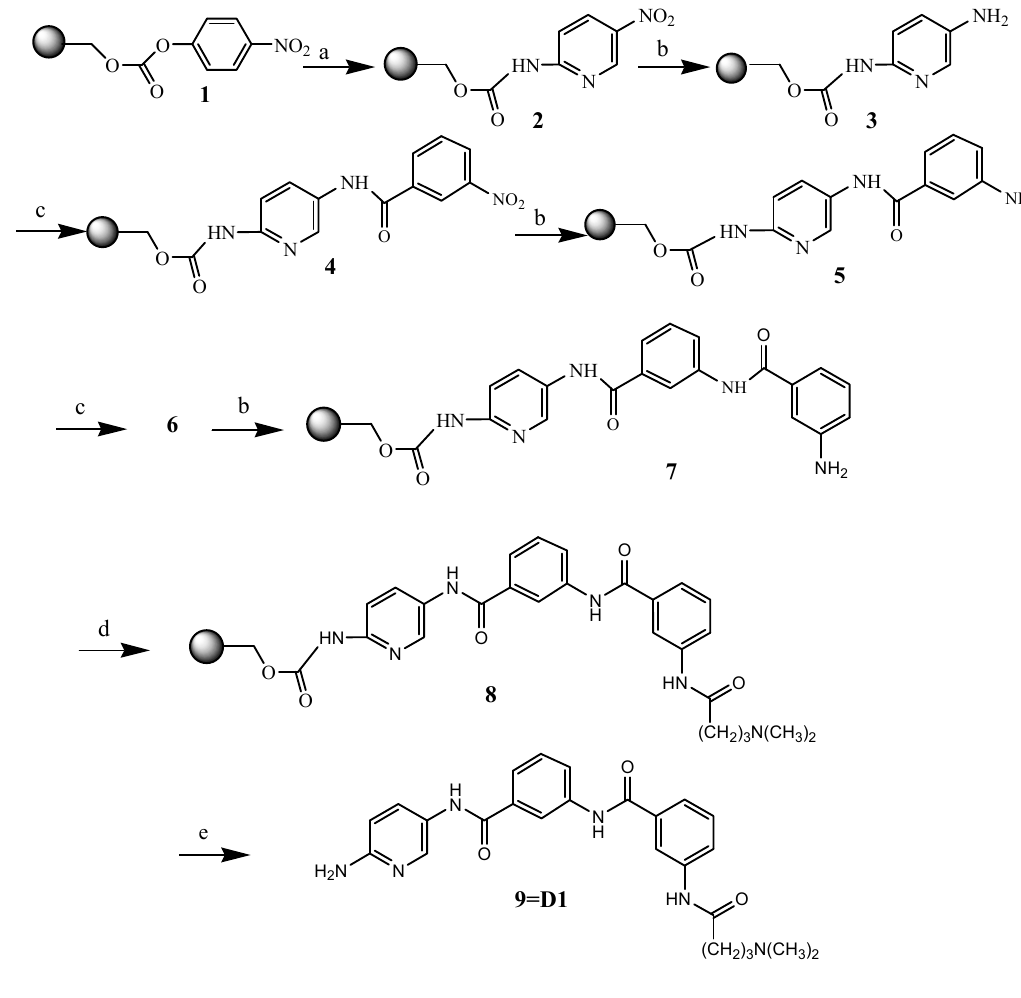
Scheme 1. Solid phase synthesis of distamycin